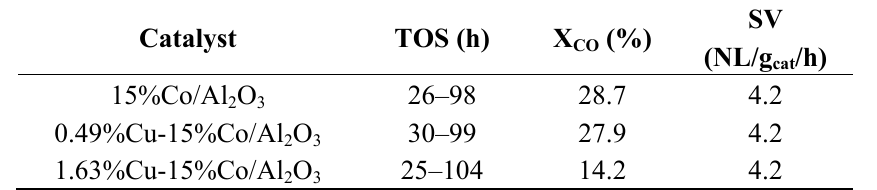
Table 1. X for two Cu promoted 15%Co/Al CO to the unpromoted catalyst. Conditions: 220 °C, 1.6 MPa, H permission from [10] Copyright 2009, Elsevier).